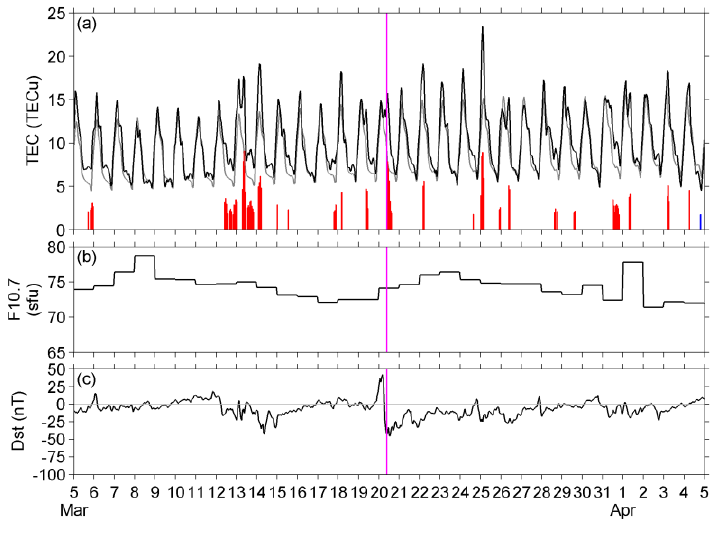
Figure 17. Same as in Figure 16, but for the second EQ.